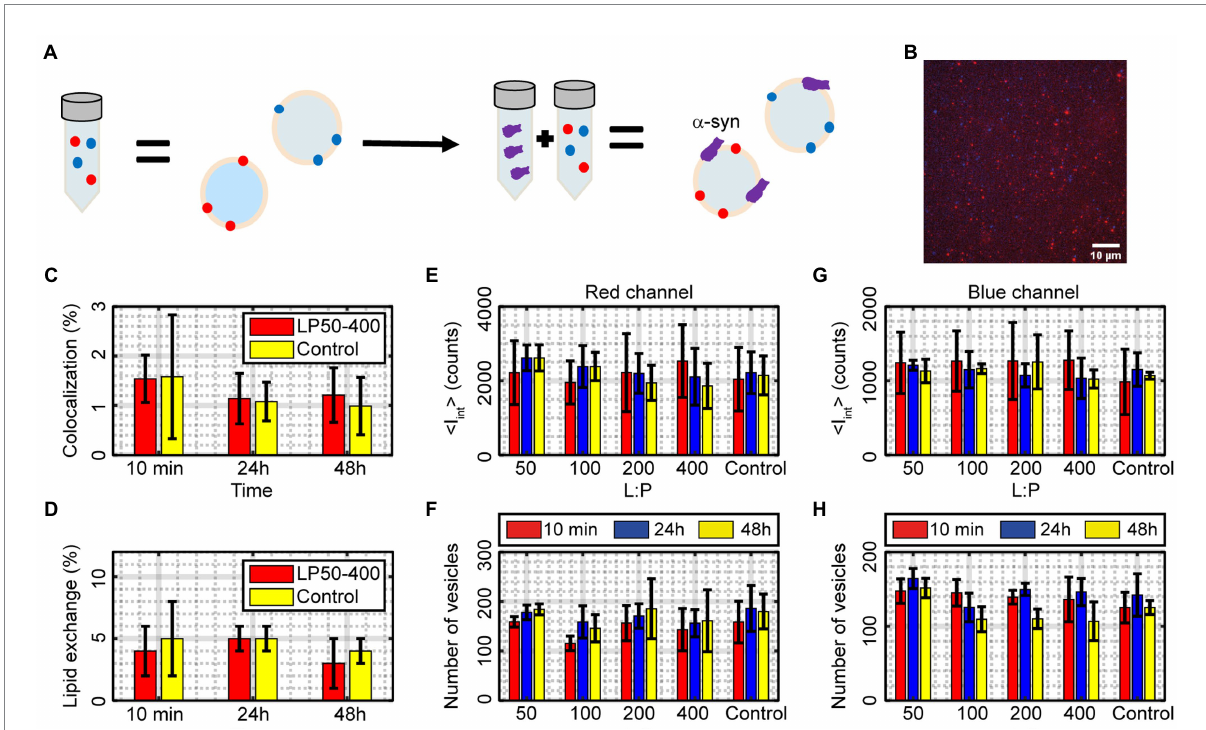
FIGURE 6 (A) Illustration of the mixing of α -syn with vesicles and the resulting outcome. (B) A fluorescence image of blue and red vesicles mixed with α -syn and docked to a glass slide for single-vesicle analysis. The image is an overlay of the two wavelength channels and the scale bar is 10 μ m. (C,D) Measured percentage of colocalized vesicles and amount of lipid exchange after incubating DOPC:DOPS vesicles with α -syn compared to vesicles without α -syn (Control). The results are averages over all L:P ranges. The data correspond to mean ± SD from n = 3 measurements. (E–H) The number of vesicles and average integrated intensity < I int > (Eq. 3) in the red and blue channel for different L:P ratios and incubation times compared to the control sample without α -syn. The data correspond to mean ± SD from n = 3